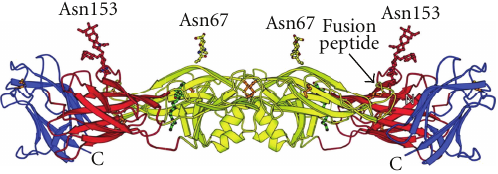
Figure 3: Location of the 2 N-glycans on the envelope protein of DENV. The DENV E-protein dimer carries 2 N-glycans on each monomer at Asn67 and Asn153. β -strands are shown as ribbons with arrows, α -helices are shown as coiled ribbons. Thin tubes represent connecting loops. Domain I is shown is red, domain II is shown in yellow and contains the fusion peptide near Asn153. Domain III is shown in blue. Disulfide bridges are shown in orange. In green, the ligand N-octyl-D-glucoside is shown, which interacts with the hydrophobic pocket between domains I and II (modified figure from Modis et al., PNAS, 2003)